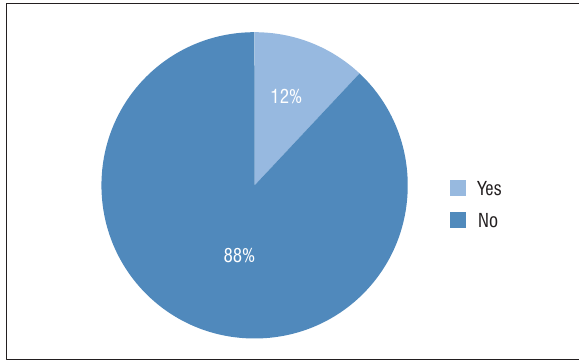
Privacy settings usage.